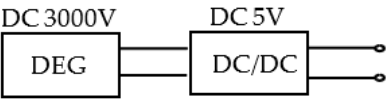
Figure 10. TOREX DC/DC converter.